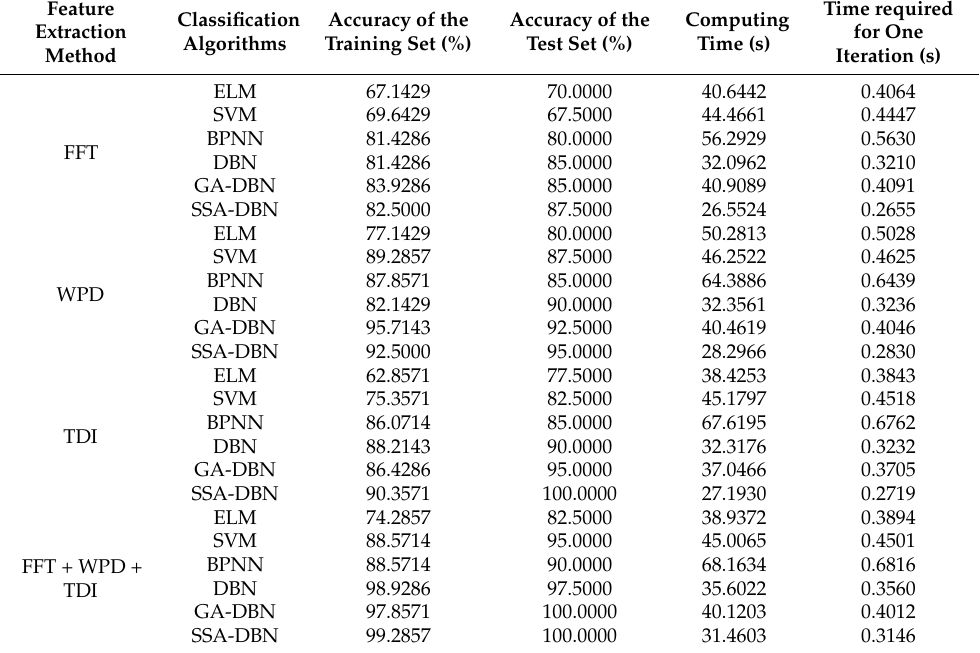
Table 6. Identification results for the on-load